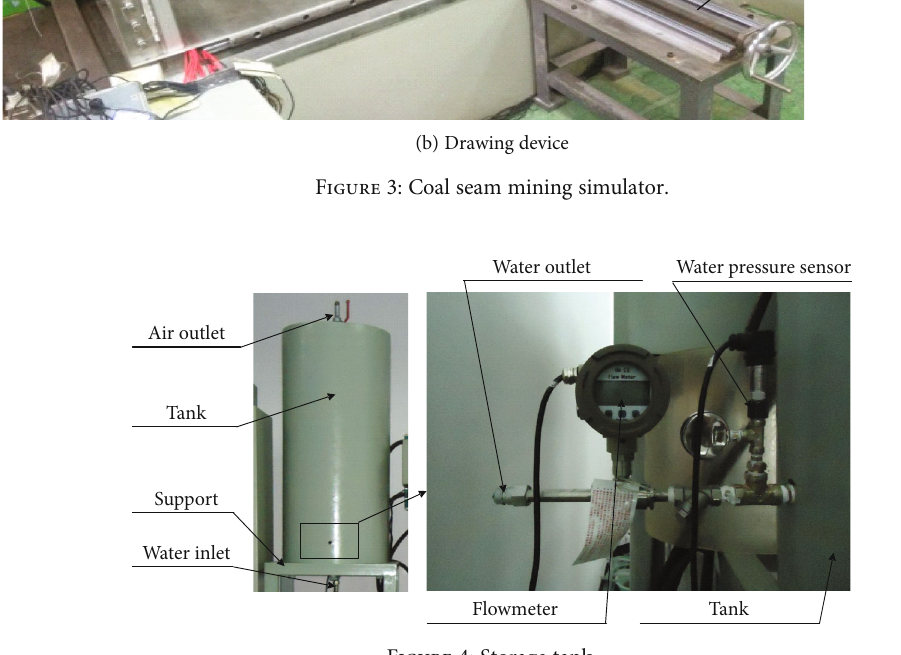
Figure 4: Storage